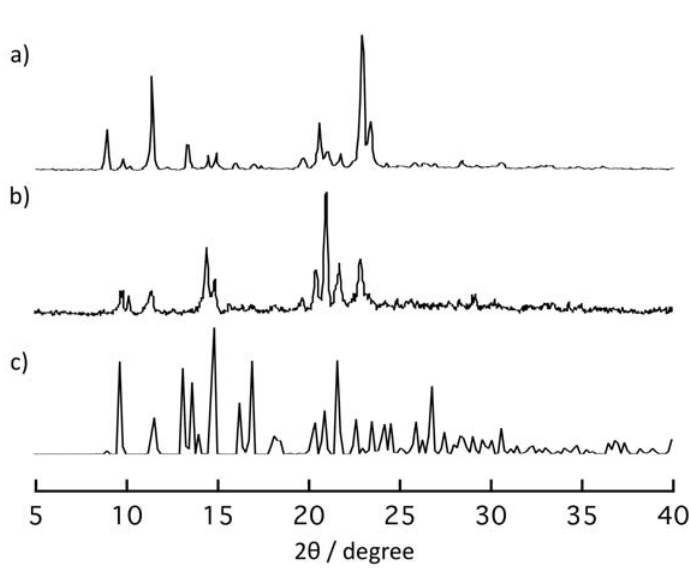
Figure S2. The XRPD pattern of powder sample of 2a ( a ). The XRPD pattern of the powder sample of 2a was exposed to EtOH vapor for three days ( b ). Simulation pattern of 2a ( c ). The XRPD patterns between (a) and (b) are not entirely consistent because of the structural defects occurred during the structural